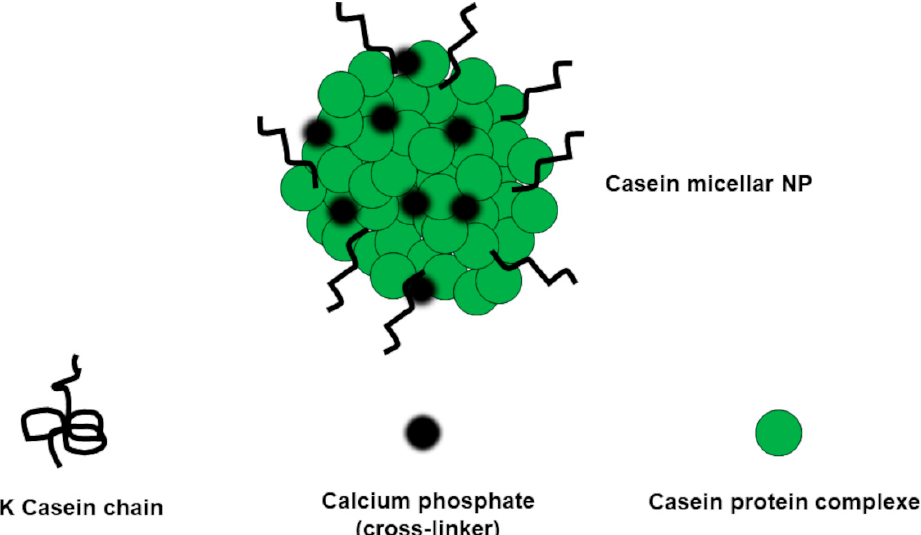
Figure 9. Schematic representation of a casein-based NP.